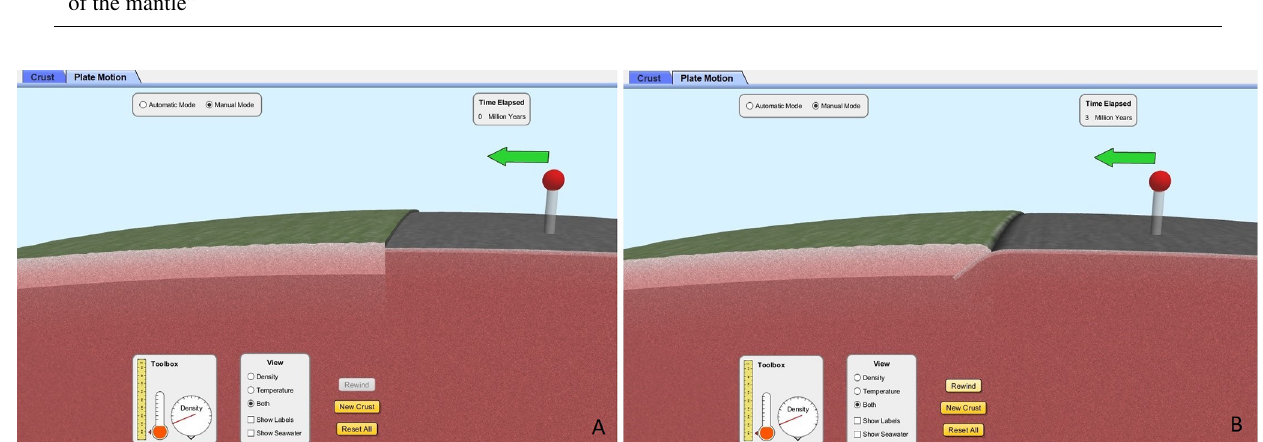
Figure 4. First image provided to PSTs that represents a convergent movement with continental and oceanic crust (a) . The simulation shows that oceanic crust suffers subduction under the continental crust (b) . Caption from PhET™ Plate